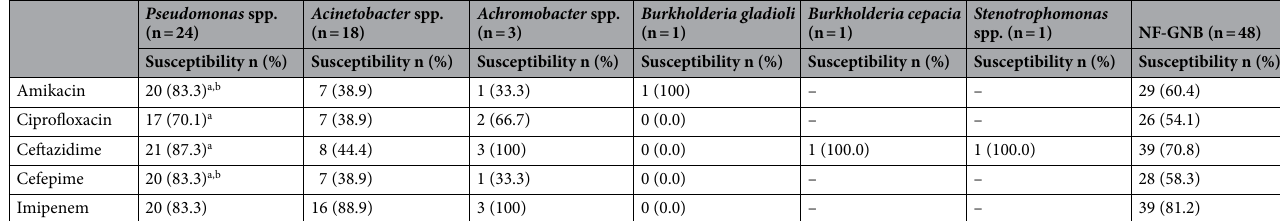
Table 3. Non-fermenting Gram-negative bacilli-causing peritoneal dialysis-related peritonitis episodes and their in vitro susceptibility rates by minimal inhibitory concentration. Data refers only to 48 recovered isolates. Statistical comparisons (Chi Square test). a p < 0.05 versus Acinetobacter spp. b p < 0.05 versus Achromobacter spp.